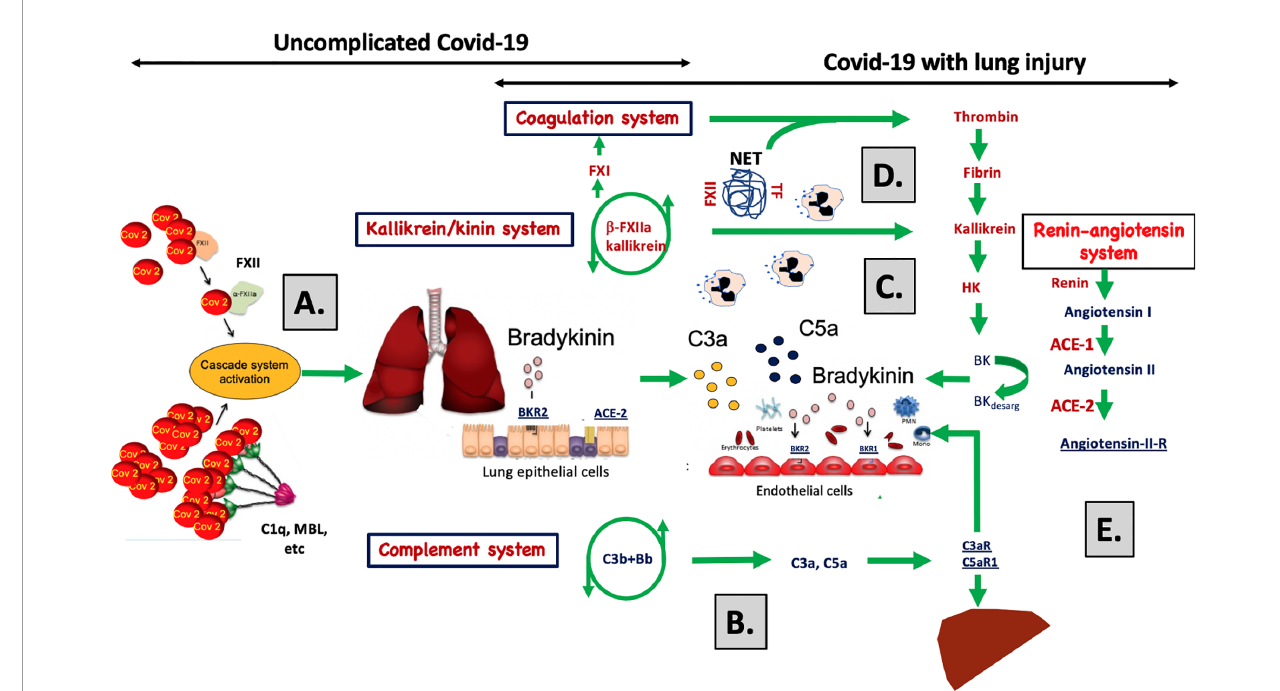
FIGURE 6 | A graphical abstract summarizing the discussion of the data obtained in the study. (A) SARS-CoV-2 infects cells via ACE-2 and C1q, MBL and FXII recognize virus particles and their products, and recognize apoptotic and necrotic cells. These reactions are tentative triggers of the classical and lectin pathways of complement and of the kallikrein/kinin system described in the present study and by others (1, 13 – 21). The elicited C3a, C5a, and bradykinin (BK) generation induce, increased vascular permeability, endothelial activation, and nerve end stimulation via bradykinin receptor (BKR) 2 (15). (B) In response to C3a and C5a, proin fl ammatory cyto-/chemokines (e.g., IL-1 b , IL-6) are produced that induce an acute in fl ammation and an acute phase reaction that increases the plasma protein (e.g., fi brinogen, MBL, C4, C3, Factor B) concentrations multi-fold and aggravate cascade system activation. (C) C5a triggers the up-regulation of BKR1, which is not constitutively expressed. BK can now act via BKR1 and BKR2 on both the pulmonary epithelium and endothelium. Together C3a, C5a, and BK have the potential to cause vascular leakage, edema, leukocyte chemotaxis, and activation that disturb oxygenation of the blood. (D) Local thrombi and pulmonary emboli further aggravate the oxygenation and cause collateral damage in other organs. Activated endothelial cells can induce thrombosis by binding MBL, FXII and by exposing tissue factor (TF) (34, 36, 50). Activation of neutrophilic granulocytes cause formation of neutrophil extracellular traps (NETs) that bind TF and triggers FXII activation (34, 35) and thereby initiating both the extrinsic and intrinsic pathways of the coagulation system. (E) The docking protein for SARS-CoV-2 on human cells is ACE-2 of the renin-angiotensin system (RAS) may cause dysregulation of the kallikrein/kinin system since BK and its metabolites are regulated directly and indirectly by the enzymes (ACE-1 and -2) of the RAS. In support of this, two of the signs and symptoms of COVID-19 can be induced as side effects during treatment of hypertension with ACE-1 inhibitors: these side effects include dry cough and increased vascular permeability (angioedema). Both of these symptoms can be alleviated by giving the patient icatibant (Firazyr ® ), an inhibitor of BKR2, suggesting that these symptoms may be caused by the kallikrein/kinin